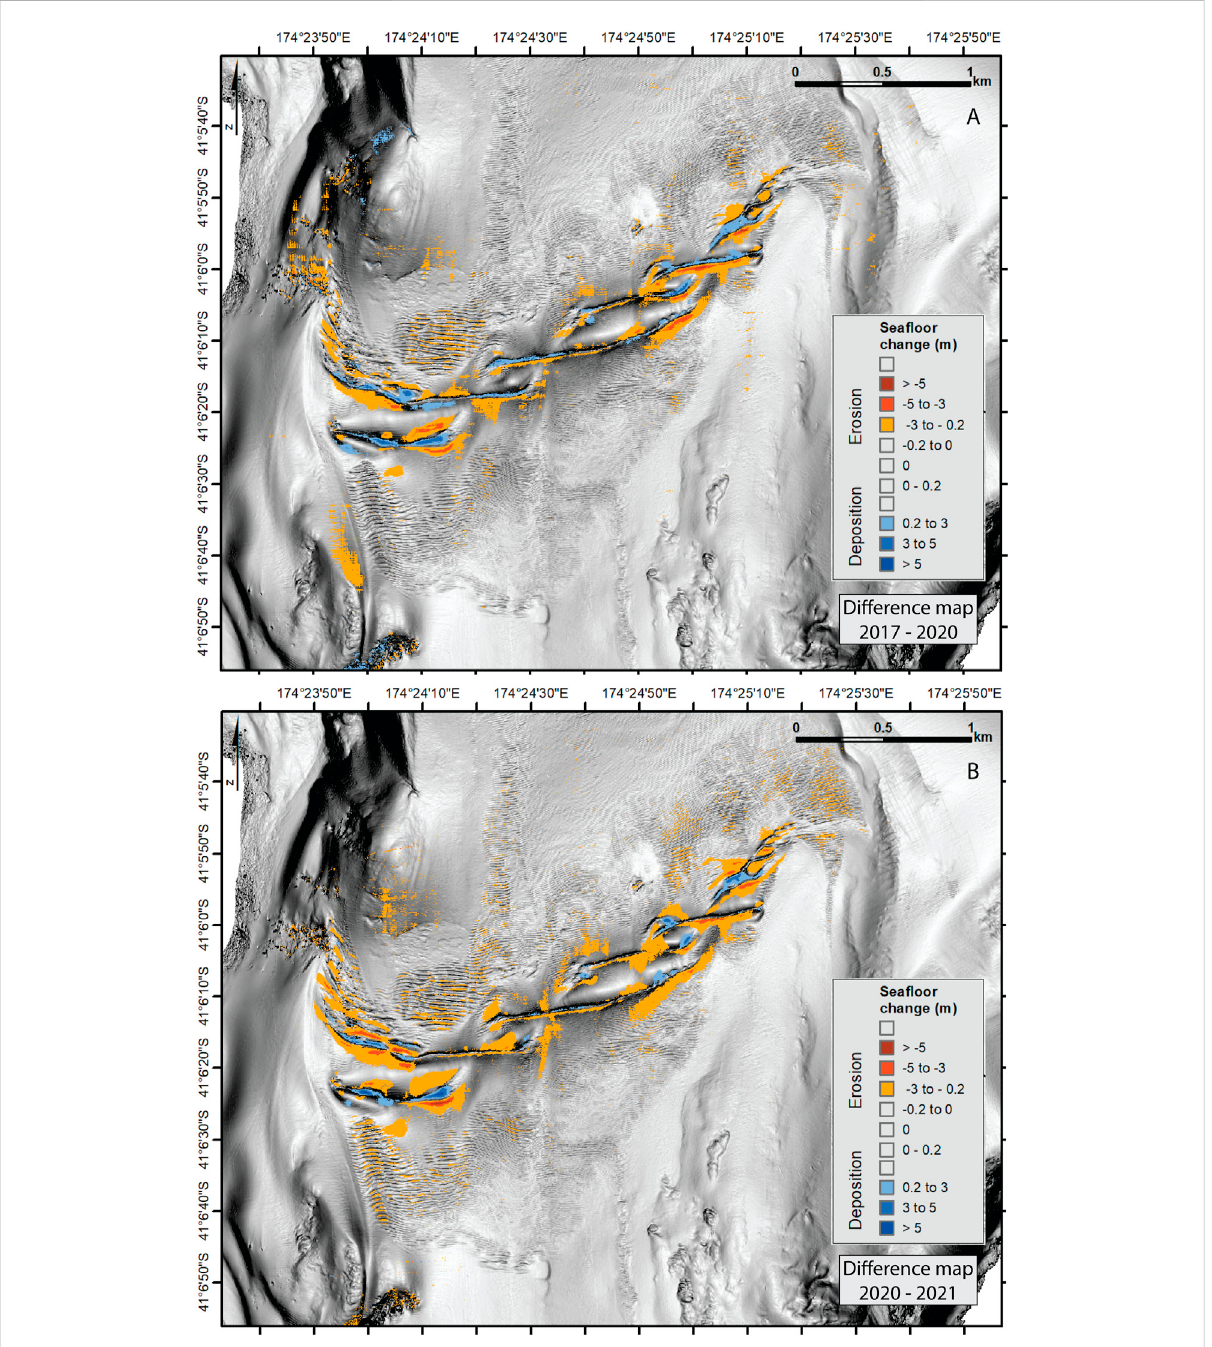
FIGURE 4 Multibeam sea fl oor slope map with overlaid magnitude of erosion and deposition measured by differencing (A) the 2017 and 2020 surveys (3- year time interval), and (B) the 2020 and 2021 surveys (1-year time interval). (Note: uncertainty in bathymetry datasets at this depth is up to ±0.2 m and has been left transparent in these fi gures to represent this). For depth information of the area, refer to Figure 3 showing depth contour lines (spaced10 m).Greyscaleshadedreliefusesslope(ratherthanhillshade)torepresentsea fl oorfeatures,toreducebiasfromarti fi ciallightsource elevation and